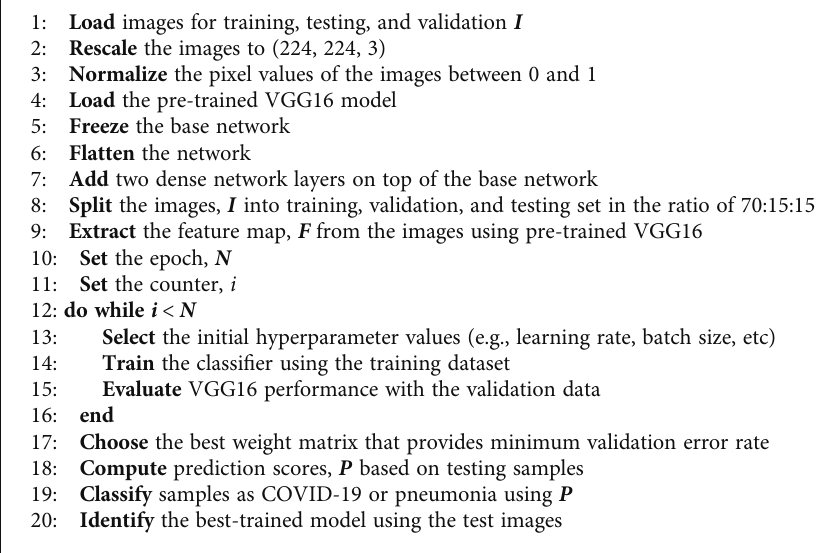
Algorithm 1: Steps to classify the X-ray images using